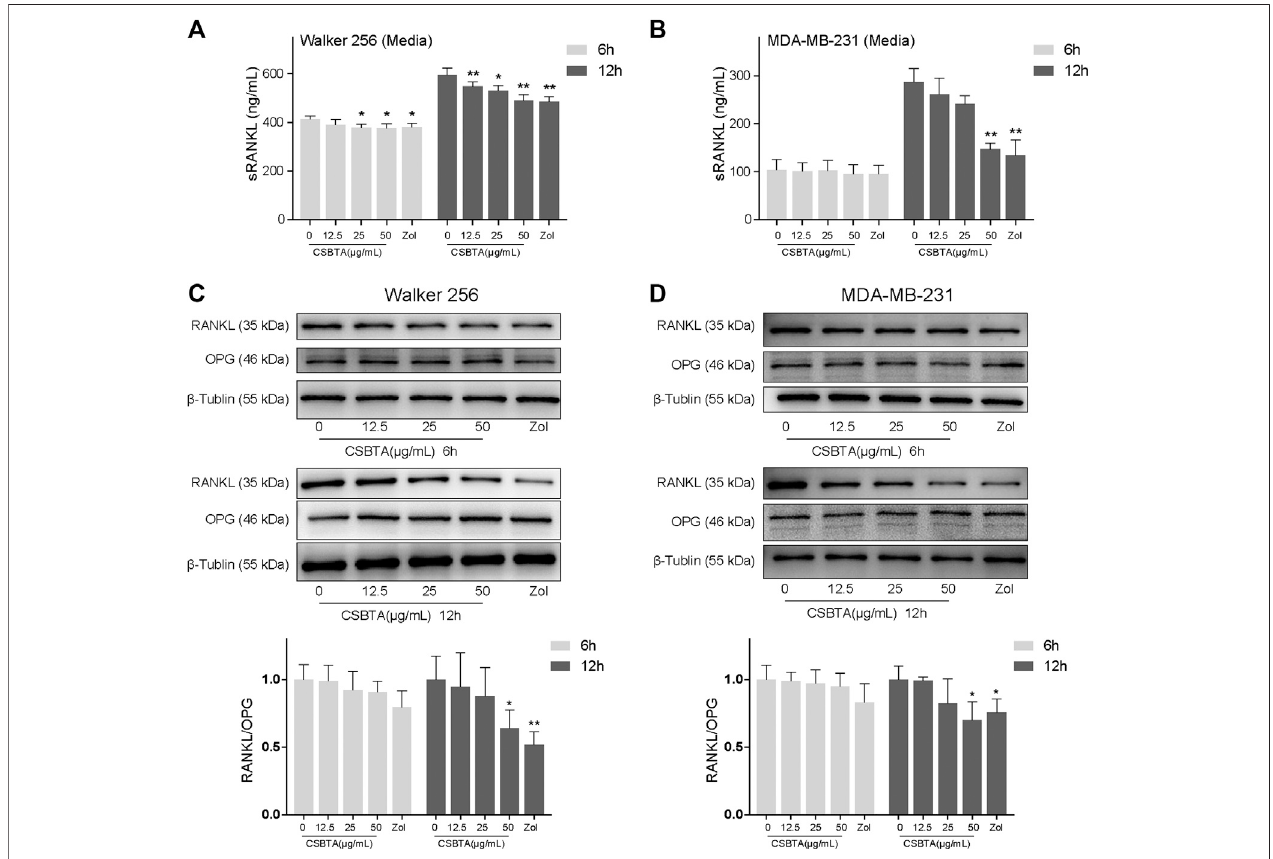
FIGURE6| CSBTAtreatmentdecreasedsRANKLsecretionandexpression.QuantitationofsRANKLsecretionofWalker256 (A) andMDA-MB-231 (B) cellmedia aftertreatmentwithCSBTAorZolfor6and12 h.ImmunoblottingfordetectionofRANKL,OPGand β -TublinproteinsinWalker256 (C) andMDA-MB-231 (D) cellsafter treatment with CSBTA or Zol for 6 and 12 h. The histogram represented fold changes of relative proteins compared with 0 μ g/ml CSBTA group. All experiments were repeated for 3 times. * p < 0.05, ** p < 0.01 vs. the 0 μ g/ml CSBTA group.